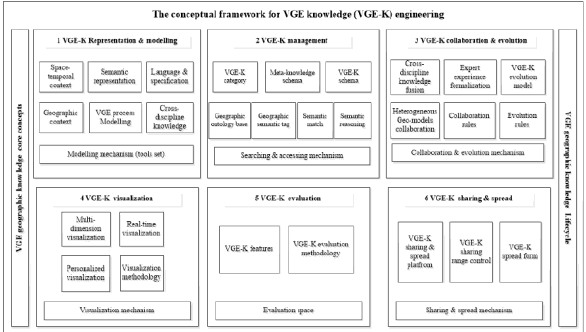
Figure 2. The conceptual framework model for VGE-K